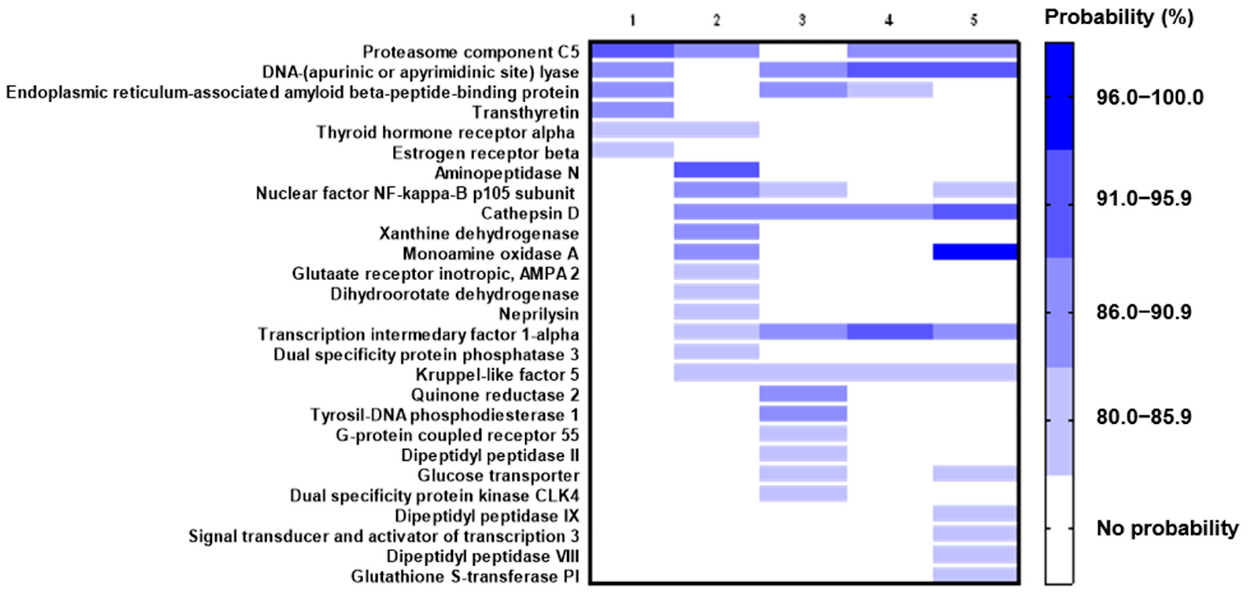
Table 1. Best 15 predicted targets, represented as UniProtKB entries (see Table S1 for protein names), for each evaluated compound using Polypharmacology browser 2 servers. Compound 1